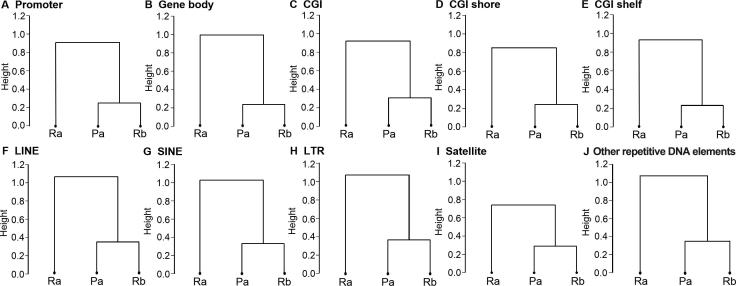
Patterns of methylome divergence for multiple functional genomic categories Methylome divergence pattern in promoter (A), gene body (B), CGI (C), CGI shore (D), CGI shelf (E), LINE (F), SINE (G), LTR (H), satellite (I), and other repetitive DNA elements (J). The methylation levels of DMFs were used for hierarchical clustering of samples. Height denotes the dissimilarity among samples.